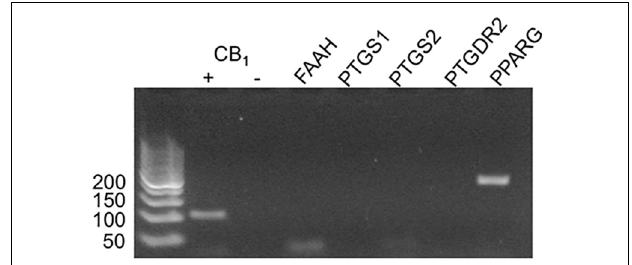
FIGURE 5 | mRNA expression of potential indomethacin targets in HEK293A cells. The expression of several gene transcripts whose protein products are considered targets for indomethacin was evaluated in HEK293A cells using RT-PCR. hCB1R cDNA was detectable in cells transfected with hCB1R-GFP 2 (+) and not untransfected cells (-). FAAH, fatty acid amide hydrolase; PTGS1 and 2, COX-1 and -2; PPARG, PPAR γ .